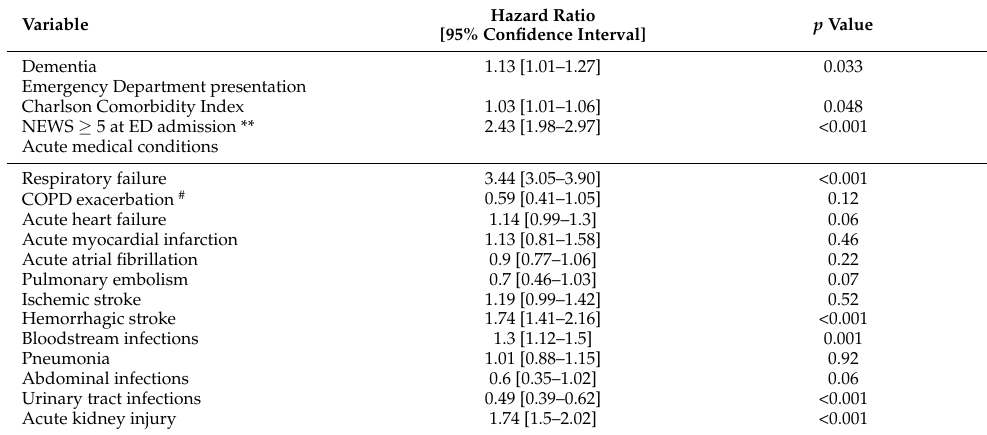
Table 4. Multivariate analysis for the whole